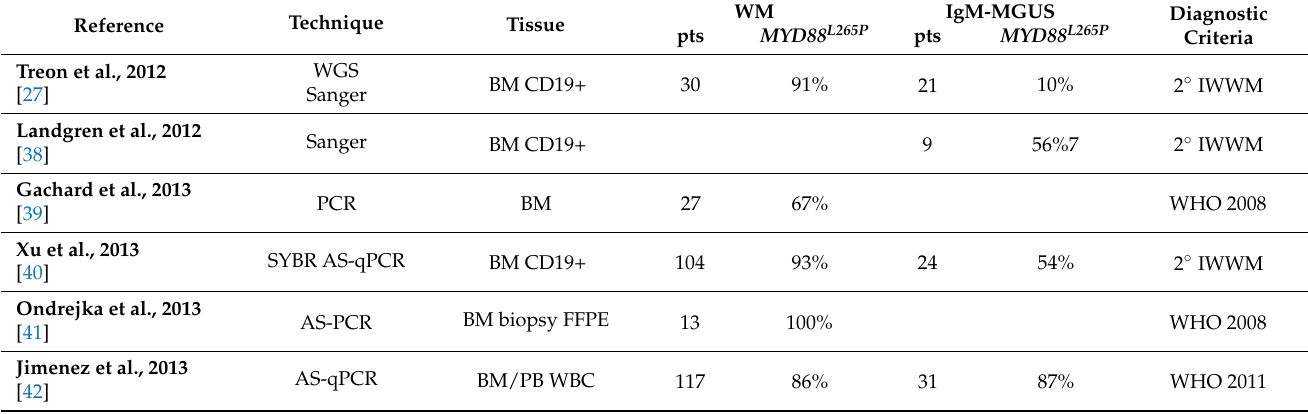
Table 1. MYD88 L265P detection in WM and IgM-MGUS. pts: patients; WM: Waldenström